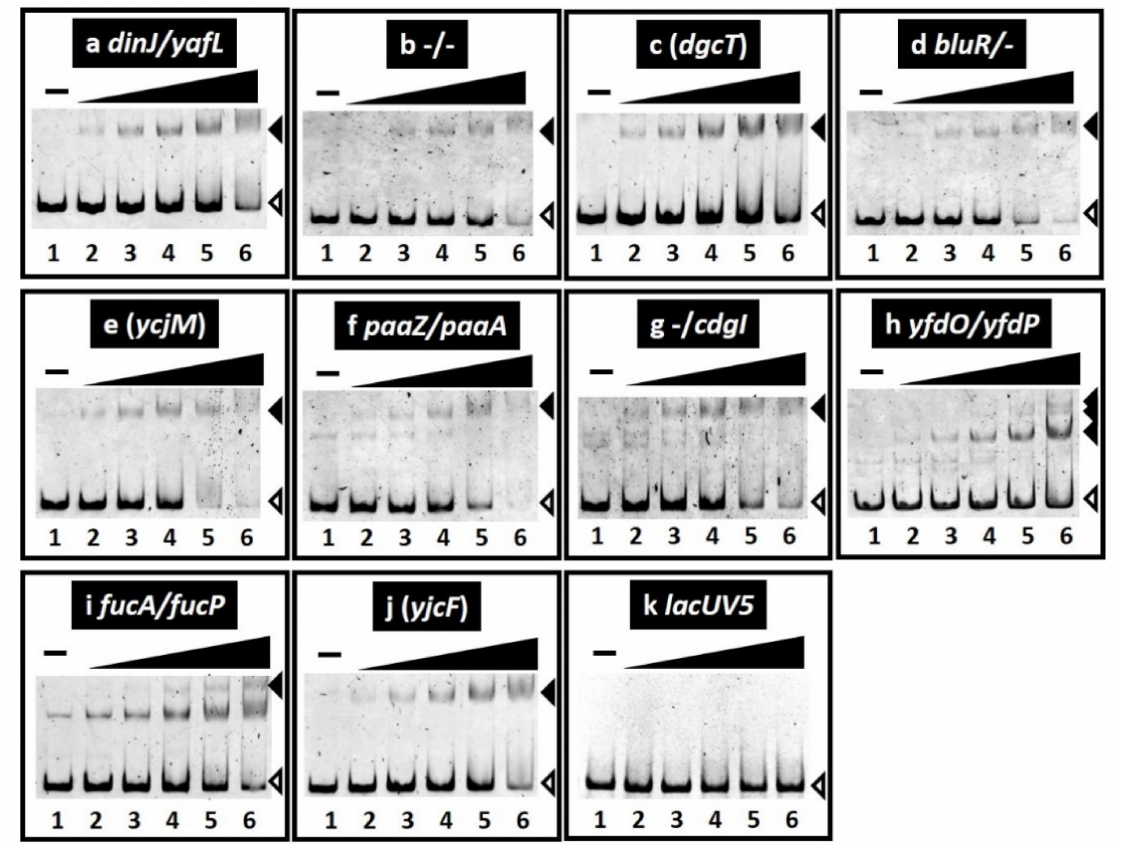
Figure 2. Gel shift assay of SrsR–DNA complex formation. ( a – k ) Purified SrsR was mixed with 0.1 pmol of each target DNA probe to the SrsR-binding regions shown in Figure 1. SrsR added were (in pmol): lane 1, 0; lane 2, 0.125; lane 3, 0.25; lane 4, 0.5; lane 5, 1; and lane 6, 2. Filled triangles indicate the SrsR–DNA probe complex whereas open triangles indicate free